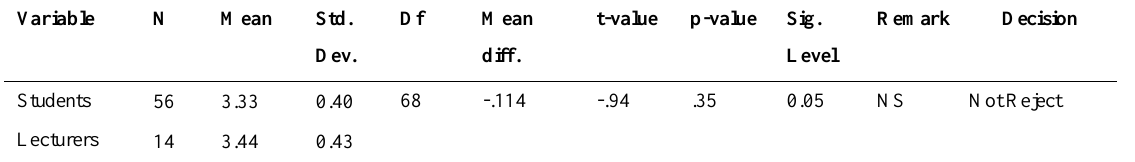
Table 10: t-test analysis of the grand mean responses of lecturers and students on how Home Page | 100 Economics will help to manage insecurity and inflation challenges in Enugu State Variable N Mean Std. Df Mean t-value p-value Sig. Remark Decision Dev. diff. Level Students 56 3.33 0.40 68 -.114 -.94 .35 0.05 NS Not Reject Lecturers 14 3.44